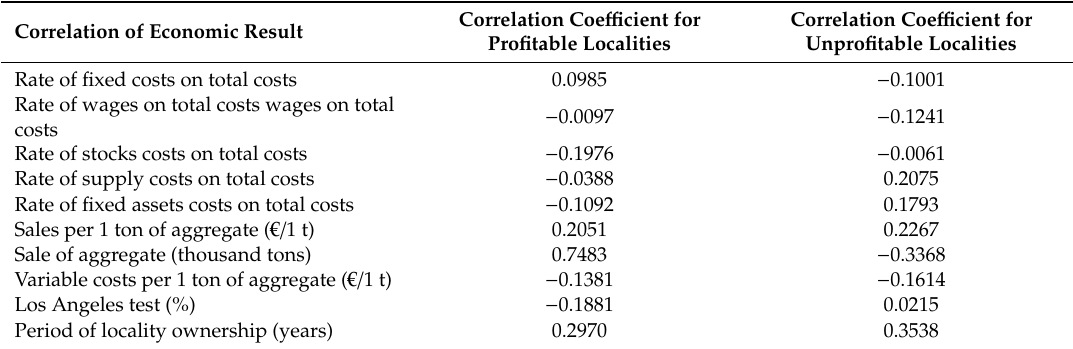
Table 4. Correlation coe ffi cient for profitable and unprofitable localities.